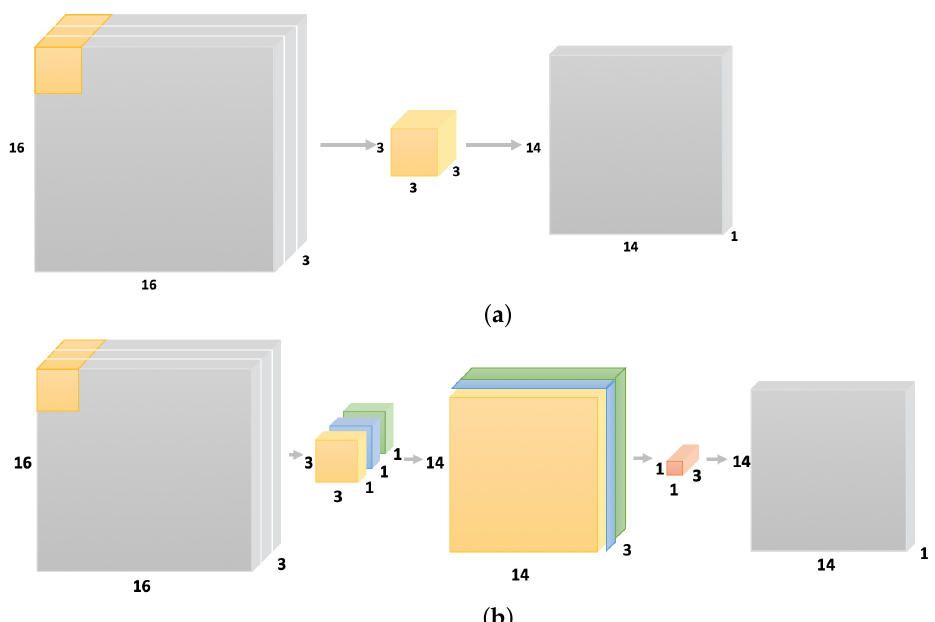
Figure 3. Traditional conventional and separable convolutional forms. ( a ) Traditional convolution. ( b ) Separable